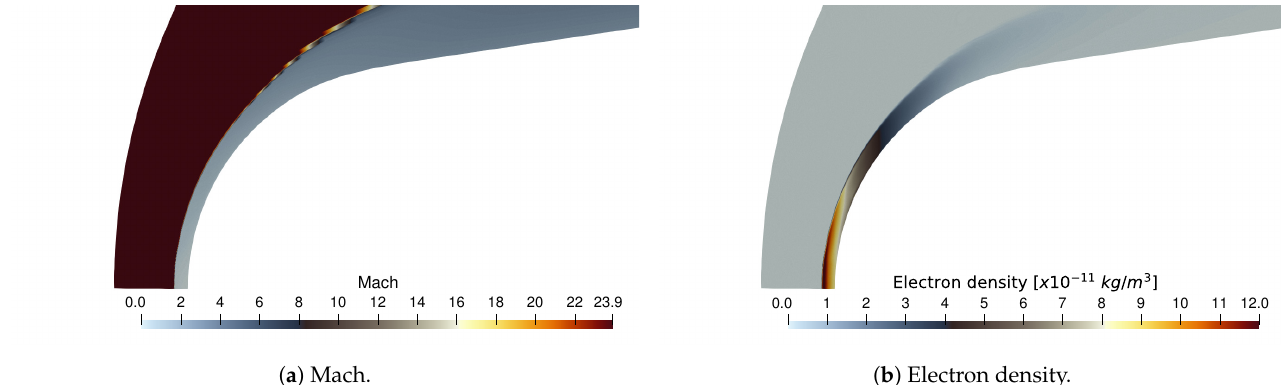
The presence of the free-electron species in the Air-7 model allows for prediction of plasma density in the vicinity of the vehicle. While more complex chemistry models, like the Air-11 model, can also be used to more accurately model the flow, Air-7 is sufficient for this case, as NO + production, due to dissociative recombination of monatomic nitrogen and oxygen, is the primary mechanism for ion formation at these flight conditions. Be- cause the plasma density is low and the primary focus is on prediction of flow properties, magnetohydrodynamic effects are neglected in this simulation. Results can be seen in Figures 8 and 9.